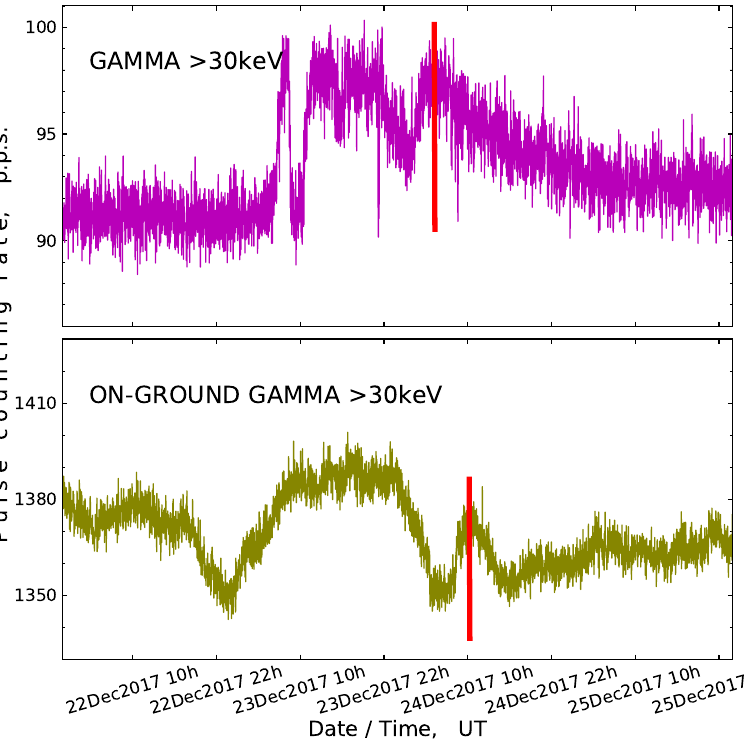
Figure 6. Comparison of the gamma radiation intensity records made before the 30 December 2017 earthquake by the detectors placed both deep in the borehole ( upper panel ) and at the surface of the ground ( lower panel ). Two mutually corresponding peaks of the counting rate of gamma rays are marked with vertical